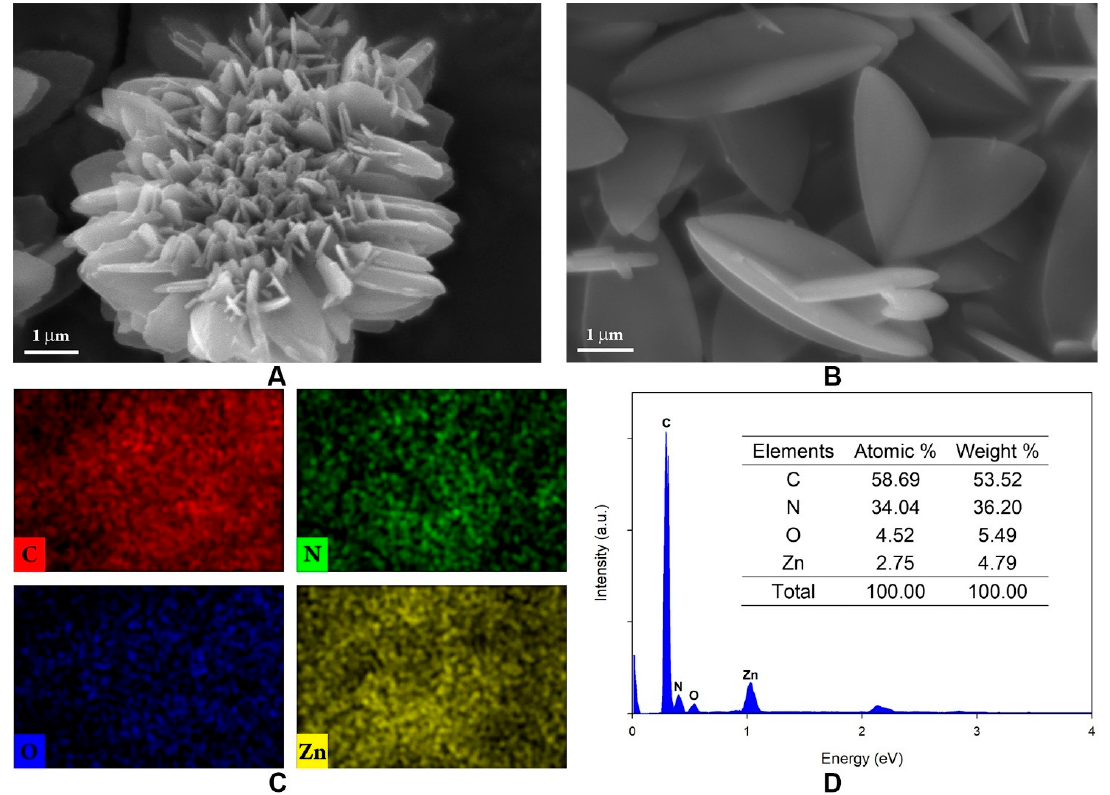
Figure 7. SEM photography of the ZIF-L synthesized ( A ) without the sonication step and ( B ) with the sonication step, along with ( C ) EDX mapping and ( D ) EDX analysis.